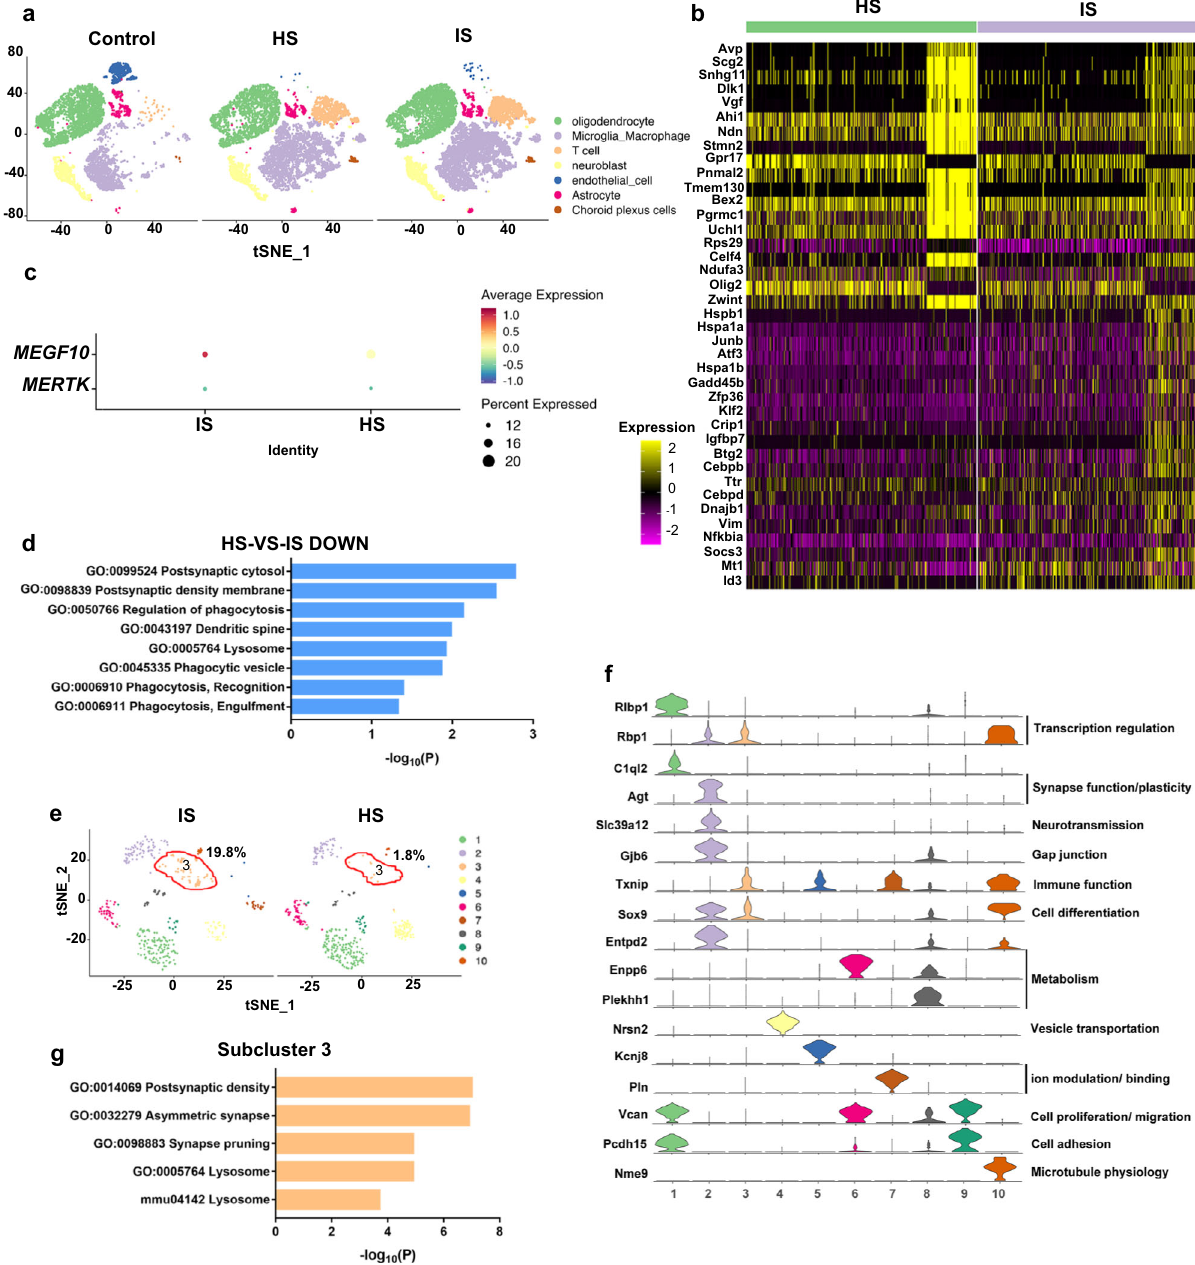
Fig. 10 scRNA-seq revealed phagocytosis-related gene expression difference of astrocytes between ischemic and hemorrhagic stroke. a tSNE map showed the expression pro fi les of the striatum in control, ischemic and hemorrhagic mice, respectively. b Heatmap showed fold change of top 20 genes. c Dot plot showing MEGF10 and MERTK expression in astrocytes. d Bar chart showed phagocytosis-related GO and KEGG pathways that downregulated in hemorrhagic stroke (HS), as compared with ischemic stroke (IS). Representative terms were shown in rows and − log 10 ( p ) in columns. e tSNE map showed subclusters of astrocytes in IS and HS. f Violin plots showed top marker genes in speci fi c astrocyte subclusters. g Bar chart showed phagocytosis-related GO and KEGG terms enriched in subcluster 3 of